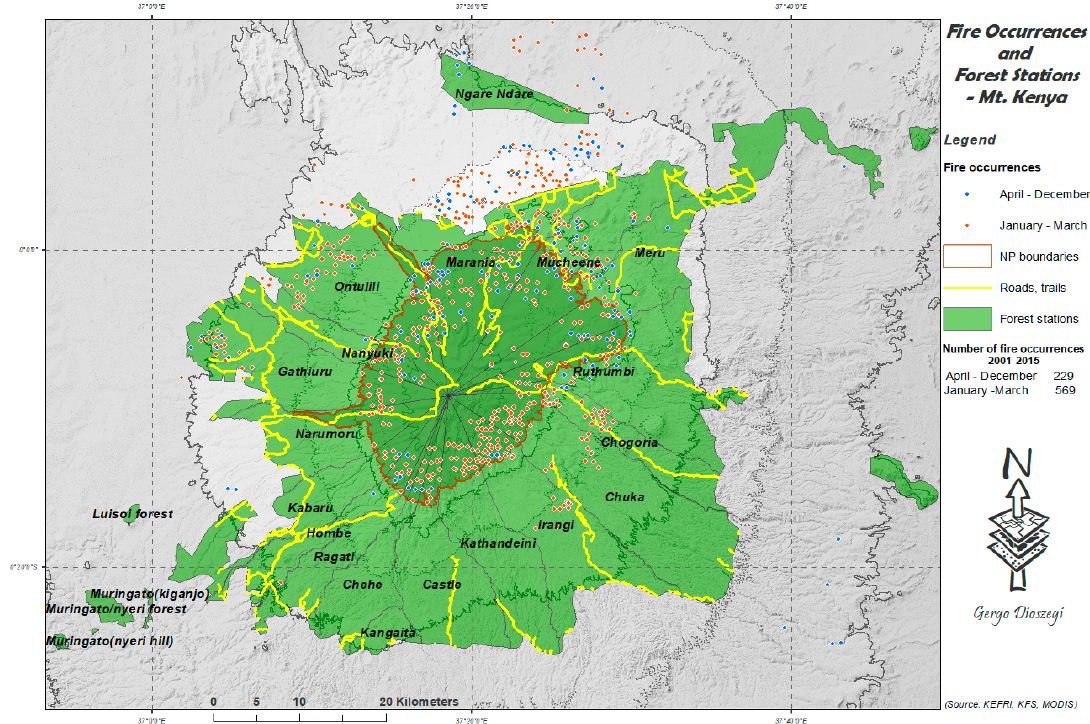
Figure 1. A map of Mount Kenya Forest and National Park showing forest stations, national park, roads, trails and the seasonal fire occurrences from 2001 to 2015 (Source: KEFRI, KFS,